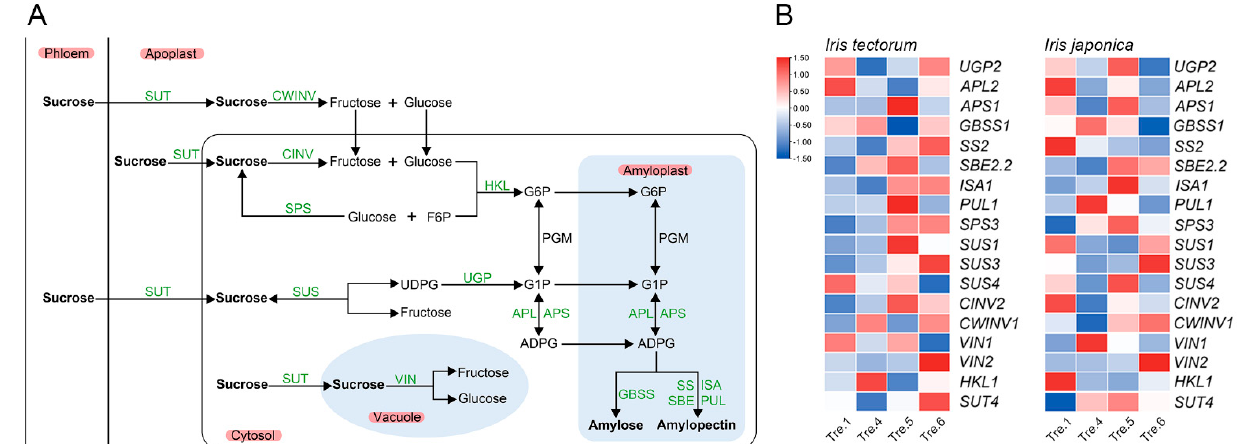
Figure 4. Transcript expression of genes associated with sucrose metabolism and starch synthesis pathways in Iris tectorum (IT) and I. japonica (IJ), under artificial dormancy induction conditions. ( A ) A schematic illustration of sucrose metabolism and starch synthesis pathways. ( B ) Transcript expression of genes associated with sucrose metabolism and starch synthesis pathways in IT and IJ under artificial dormancy induction conditions. Red denotes that the gene is upregulated, whereas blue represents that the gene is downregulated. Gene full names are shown in Supplemental Table S1.